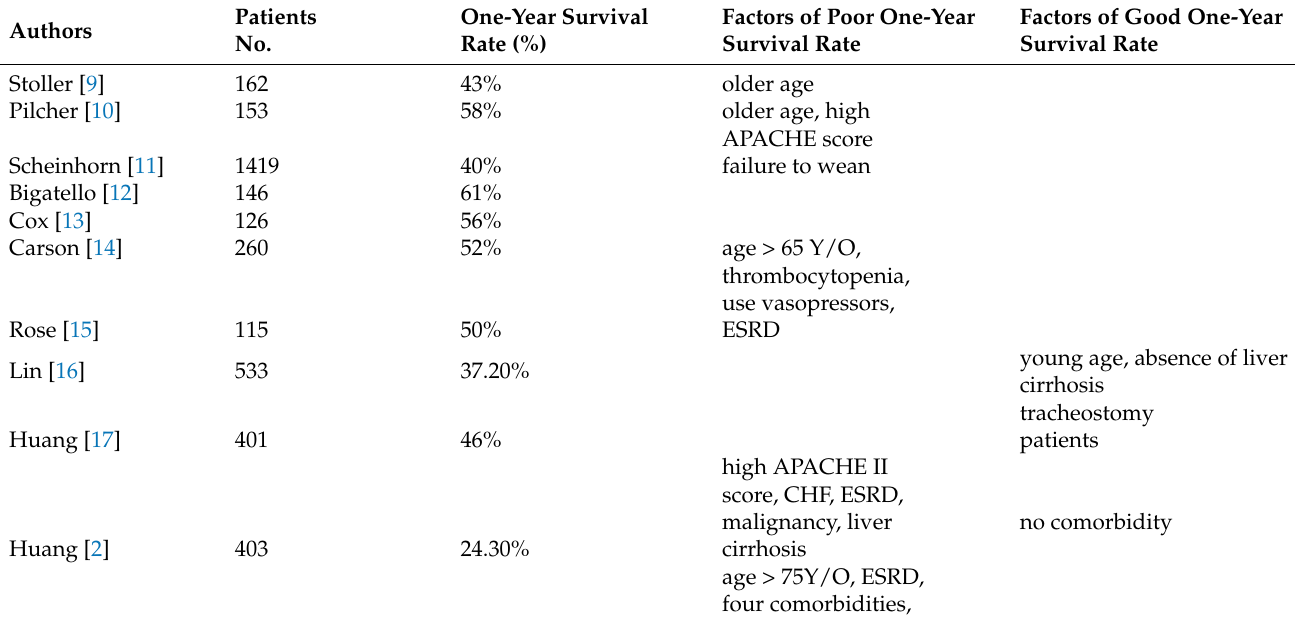
Table 3. The one-year survival of patients requiring prolonged mechanical